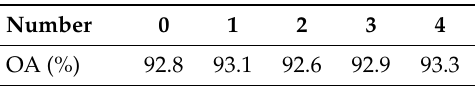
Table 3. The overall accuracy (OA) with different number of Spatial-Attention EdgeConv replacing normal EdgeConv. We first remove all SE-Blocks and the Global-Attention Module in Figure 2. Then, we replace different number of common EdgeConv with Spatial-Attention EdgeConv (from left to right in Figure 2).